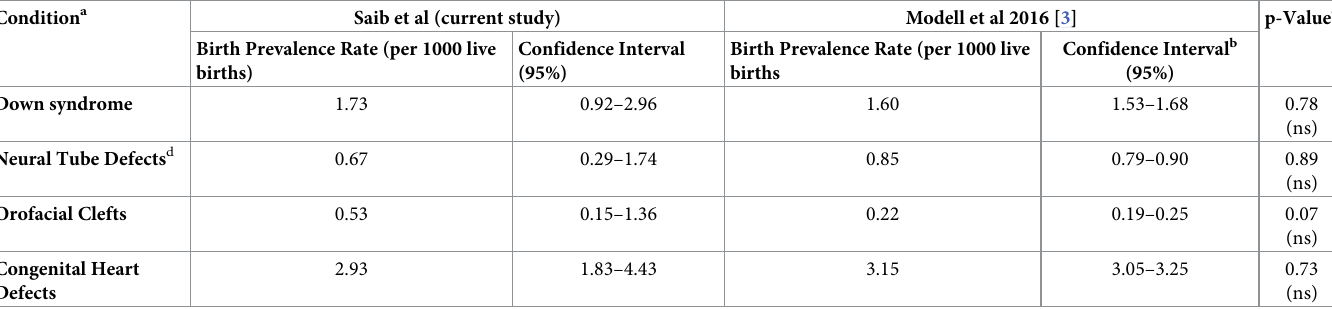
Table 4. Comparison of observed (EDH) with modelled (SA) birth prevalence rates of selected congenital anomalies. Condition a Saib et al (current study) Modell et al 2016 [3] p-Value c Birth Prevalence Rate (per 1000 live births)